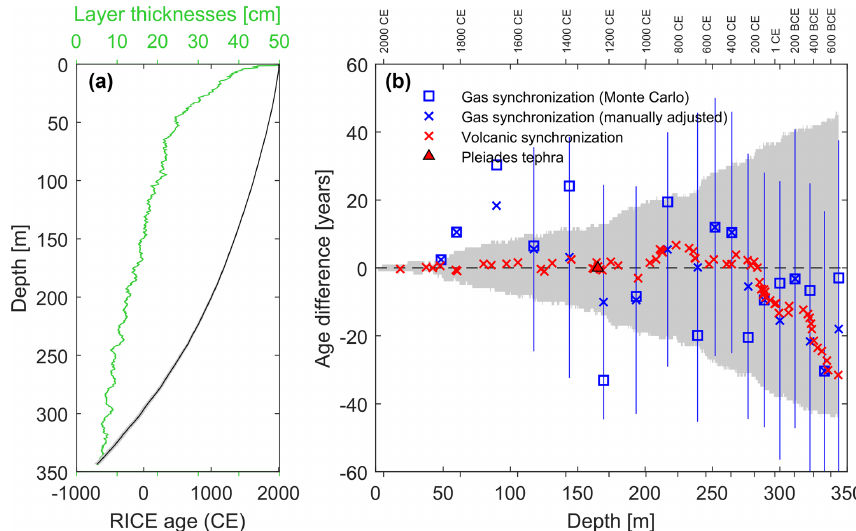
Figure 9. (a) Depth evolution of RICE17 ages (black), including the associated 95% confidence interval (grey area, almost invisible due to scale) and corresponding mean layer thicknesses (50-year running mean; green). (b) Comparison of RICE17 ages and confidence interval (grey area) to WD2014 from volcanic (red) and gas (blue) matching to WAIS Divide. A negative age difference implies fewer layers in RICE17 than in WD2014. Blue vertical lines represent 0.5 σ age uncertainties on the ice age scale from Monte Carlo methane matches and delta-age modeling. The solid red triangle indicates the Pleiades tephra layer at 165m of